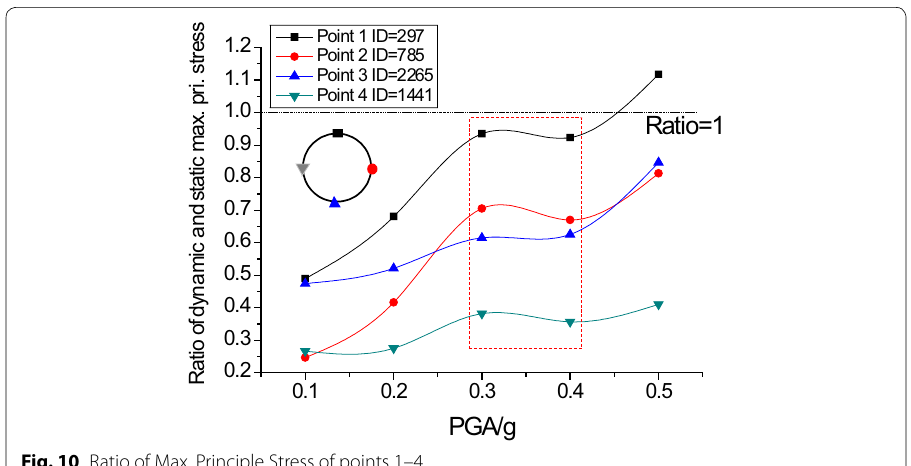
Fig. 10 Ratio of Max. Principle Stress of points 1–4